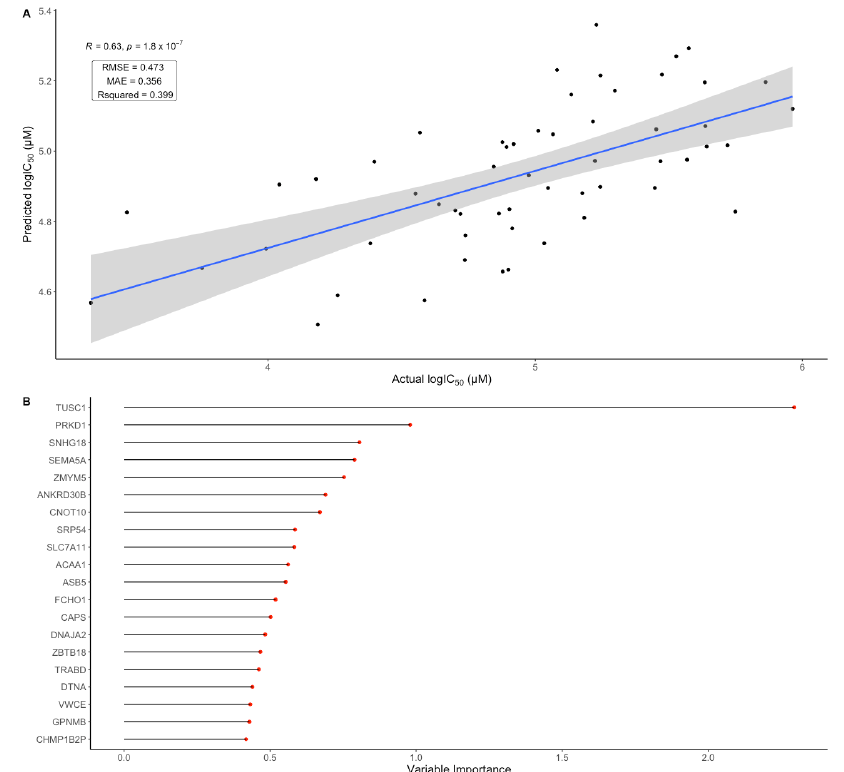
Figure 5. Evaluation of the random forest regression model fitting BOLD-100 sensitivity to gene expression data. ( A ) Model evaluation using the Pearson correlation between the model predicted BOLD-100 IC 50 values on the test dataset and the measured IC 50 values from the cell panel. Blue line represents the linear line of best fit and the gray shaded area represents the 95% confidence interval for the line of fit. The root-mean-squared-error (RMSE), mean-absolute-error (MAE), and R 2 are reported for the model evaluation. ( B ) Variable importance of genes in the BOLD-100 IC 50 prediction model. Top 20 features are shown. X-axis denotes the variable importance score, which is measured by the Gini impurity method.